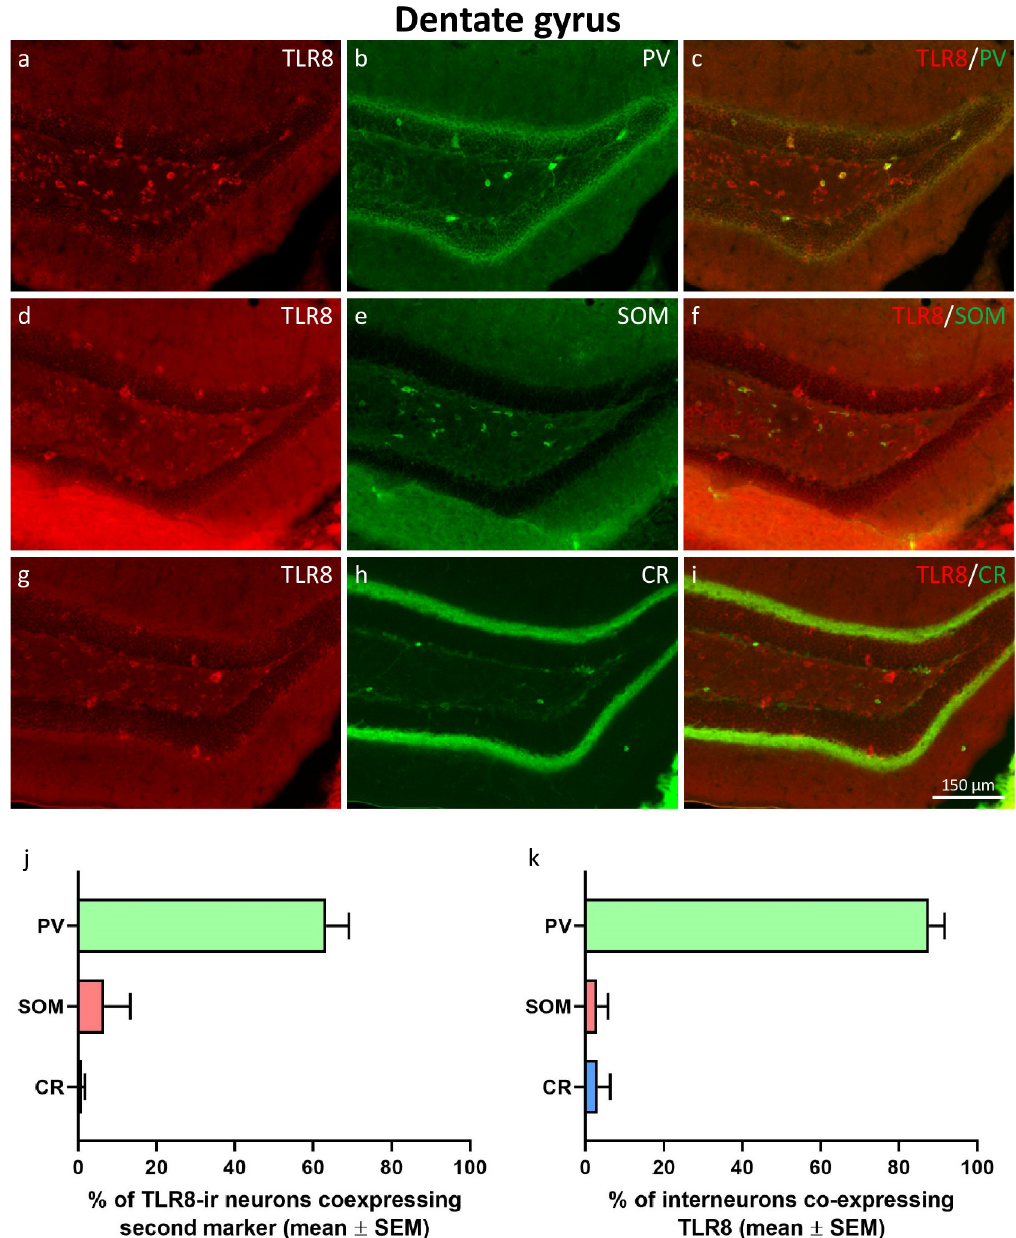
Fig 2. Expression of TLR8 in GABAergic interneurons of the dentate gyrus. Double immunofluorescence of TLR8 (red fluorescence; a, d, g) with parvalbumin (PV; b, c), somatostatin (SOM; e, f), and calretinin (CR; h, i). TLR8 was predominately expressed in PV-positive interneurons and to a minor extent in SOM- or CR-expressing GABAergic interneurons. Quantification of double-labeling revealed that 63.4 ± 5.70% of TLR8-expressing neurons also expressed PV, but only 6.7 ± 6.67% expressed SOM, and 0.9 ± 0.86% expressed CR (j). Vice versa, 87.7 ± 4.04% of PV-interneurons co-expressed TLR8, but only 2.9 ± 2.86% and 3.1 ± 3.13% of SOM- and CR-interneurons co-expressed TLR8,